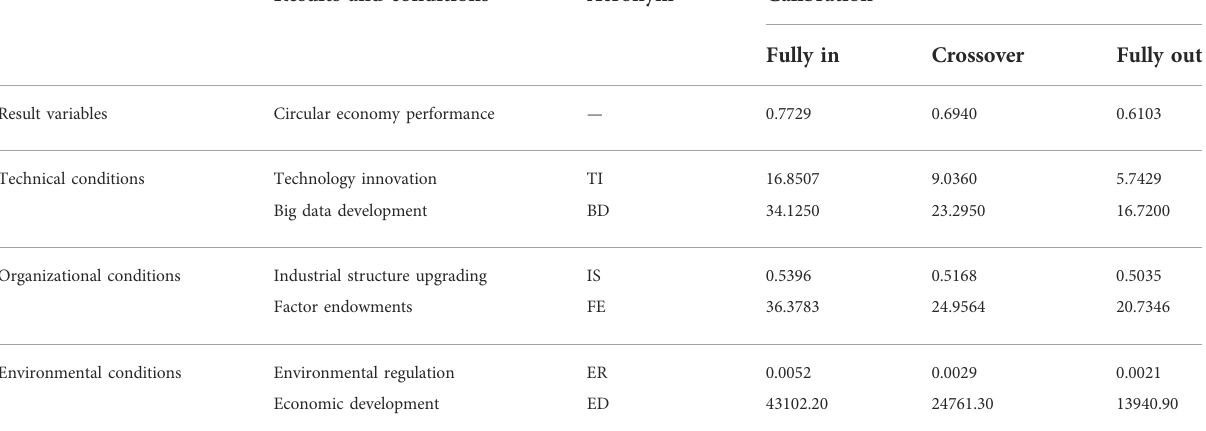
TABLE 2 Variable